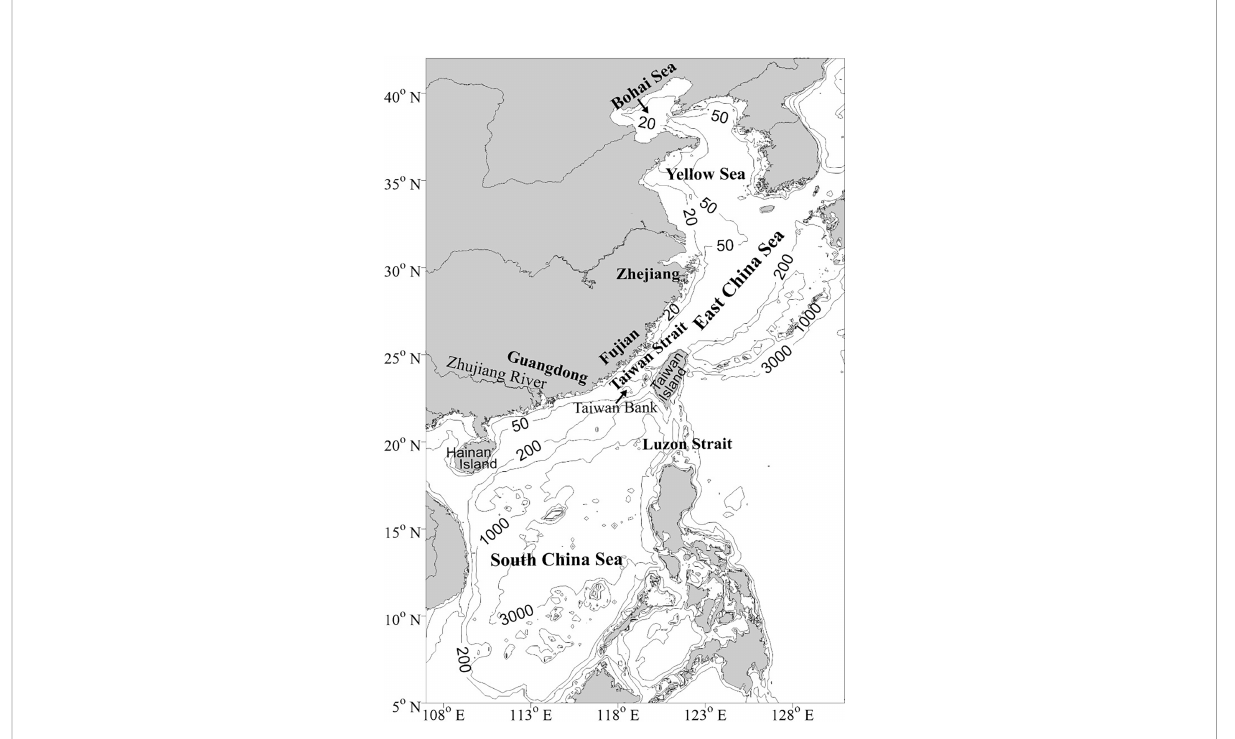
FIGURE 1 Research domain and bathymetry. The bathymetry data is from ETOPO2 (U.S. National Geophysical Data